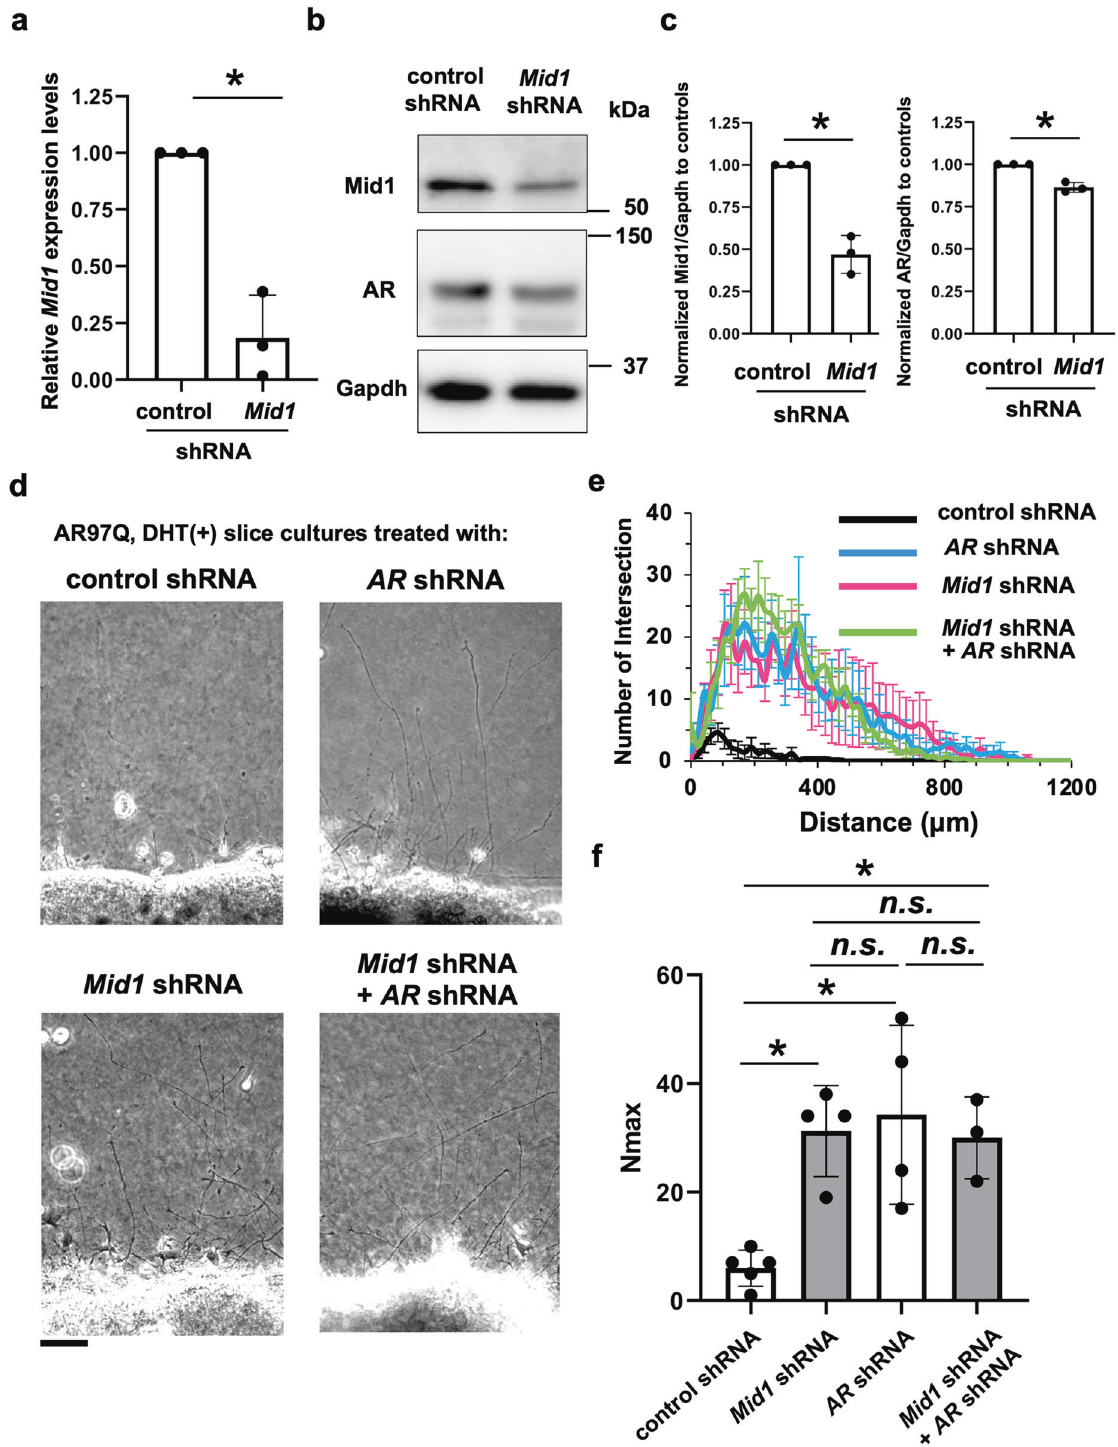
Fig. 7 Amelioration of axonogenesis impairment by Mid1 knockdown in SBMA. a Quanti fi cation of Mid1 expression levels in the spinal cord slice cultures from wild-type mouse fetus transfected with lentivirus expressing control shRNA or Mid1 shRNA. Statistically, signi fi cant difference (* p < 0.05) was detected by an unpaired two-tailed one-sample t -test. b Immunoblots showing levels of Mid1, AR, and Gapdh in the spinal cord slice culture from AR-97Q male mouse fetus transfected with control shRNA or Mid1 shRNA. c Quantitative densitometry analyses of Mid1 and human AR levels in a ( n = 3 samples per group). d Phase-contrast images showing the effects of Mid1 and/or human AR knockdowns on the axonogenesis of the spinal cord slice culture from AR-97Q mouse fetus treated with DHT. e For the spinal cord slice cultures from AR-97Q male mouse fetus treated with DHT and shRNA (control, Mid1 , human AR , or both Mid1 and human AR ), plots showing the quanti fi cation of the intersection pro fi le was obtained by Neurite-J. f Comparisons of the maximal number of axons detected in an image ( N max ). Statistically, signi fi cant differences (* p < 0.05) were detected by Tukey ’ s multiple comparisons test.